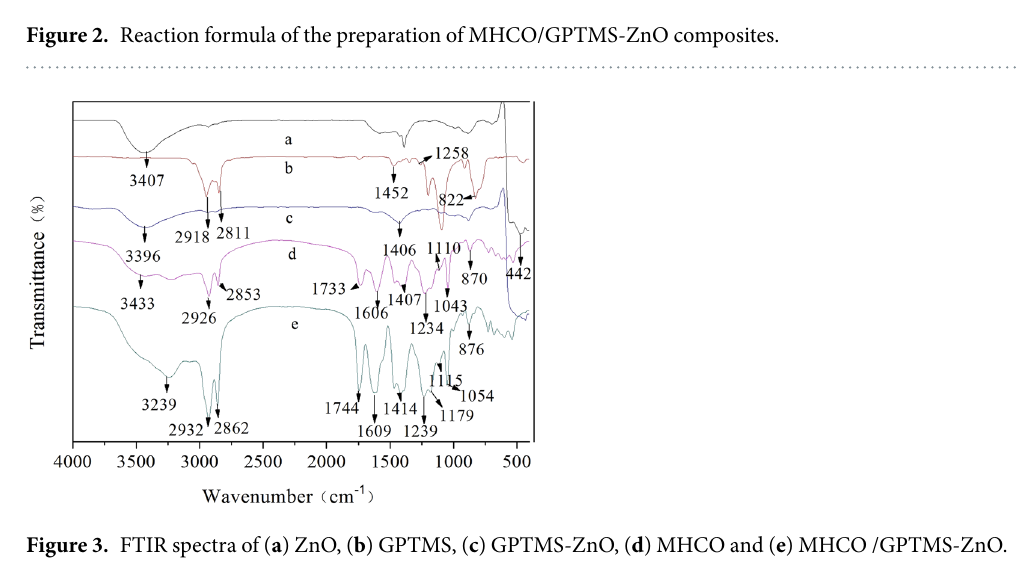
Figure 3. FTIR spectra of ( a ) ZnO, ( b ) GPTMS, ( c ) GPTMS-ZnO, ( d ) MHCO and ( e ) MHCO